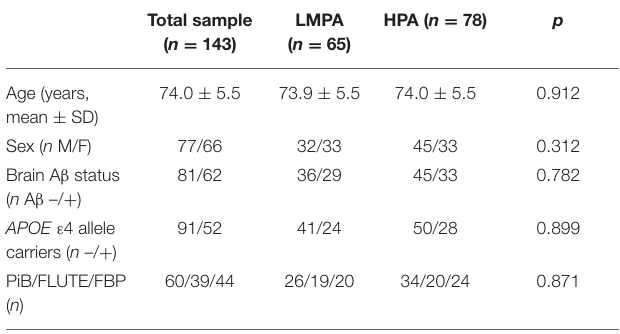
TABLE 2 | Comparison of plasma biomarkers between low-to-moderate physical activity (LMPA) and high physical activity (HPA) groups.